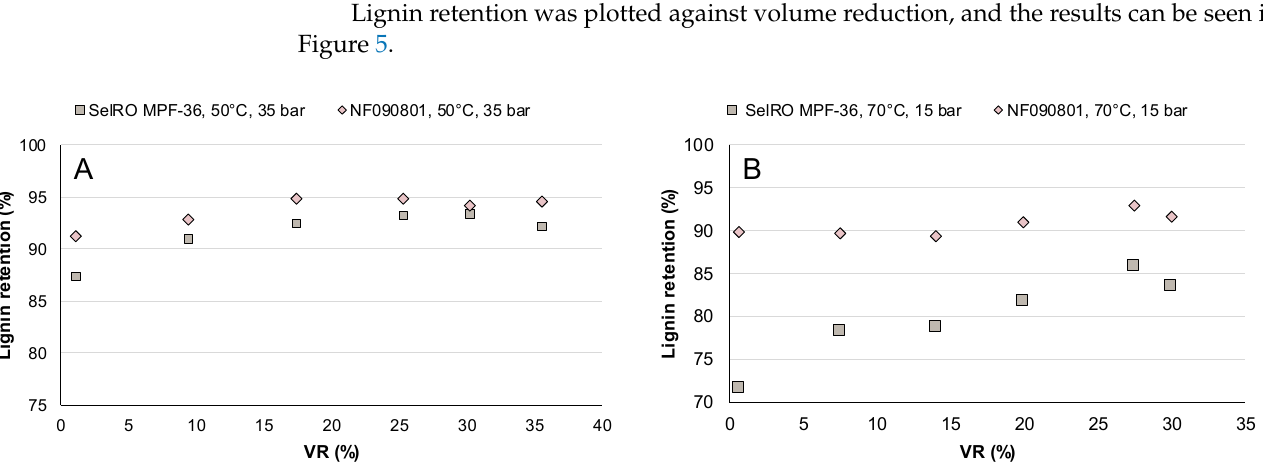
Figure 5. Lignin retention vs VR during the concentration studies with the SelRO MPF-36 and NF090801 membranes at ( A ) condition A, 50 °C and 35 bar, and ( B ) condition B, 70 °C and 15 bar.